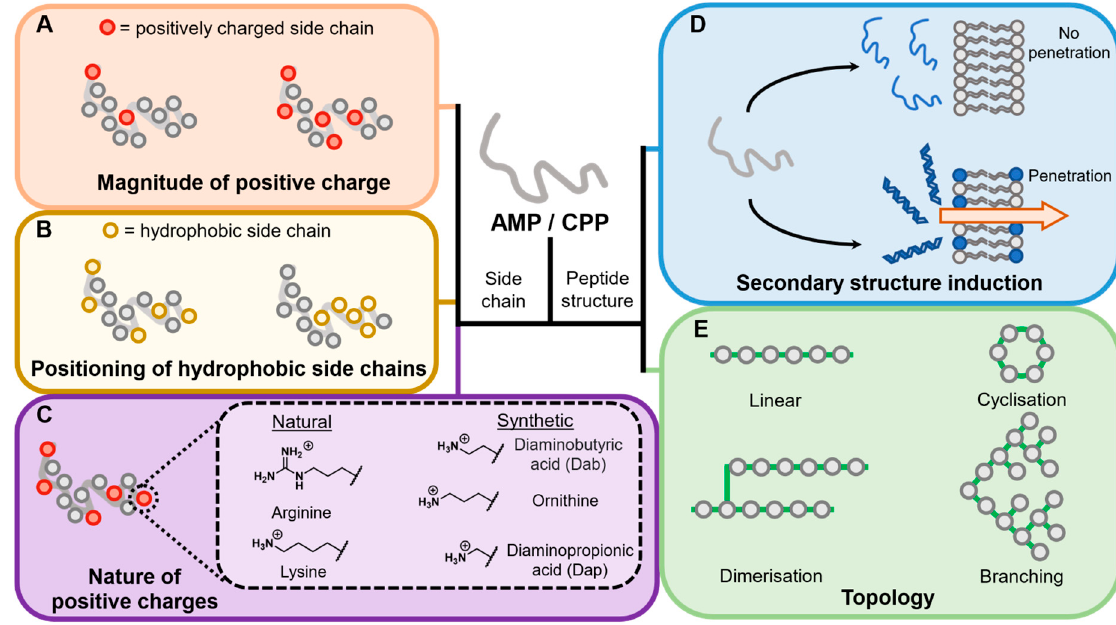
Figure 3. Characteristics of a peptide which affect penetrability. Positive charge ( A ), positioning of hydrophobic side chains ( B ) and the nature of positive charge ( C ) are some of the side chain characteristics that can affect penetrability. Secondary structure induction ( D ) and topology ( E ) are some of the structural characteristics that can affect penetration.